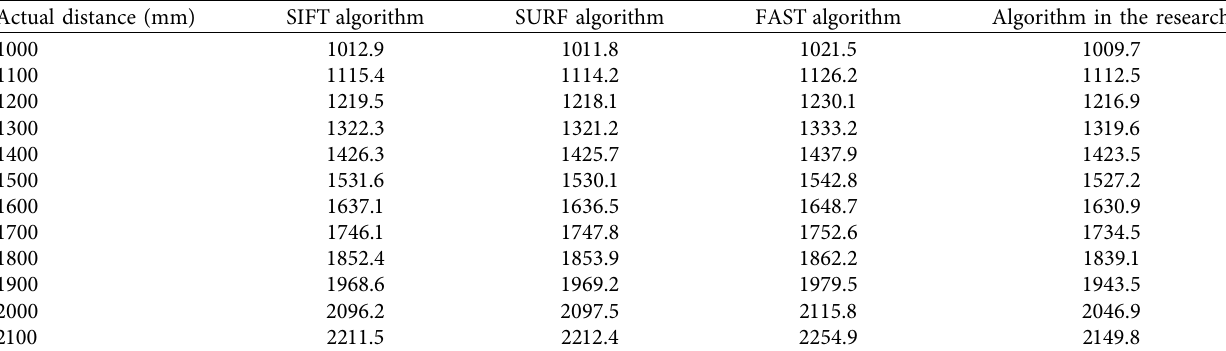
Table 6: Ranging results of four matching algorithms.